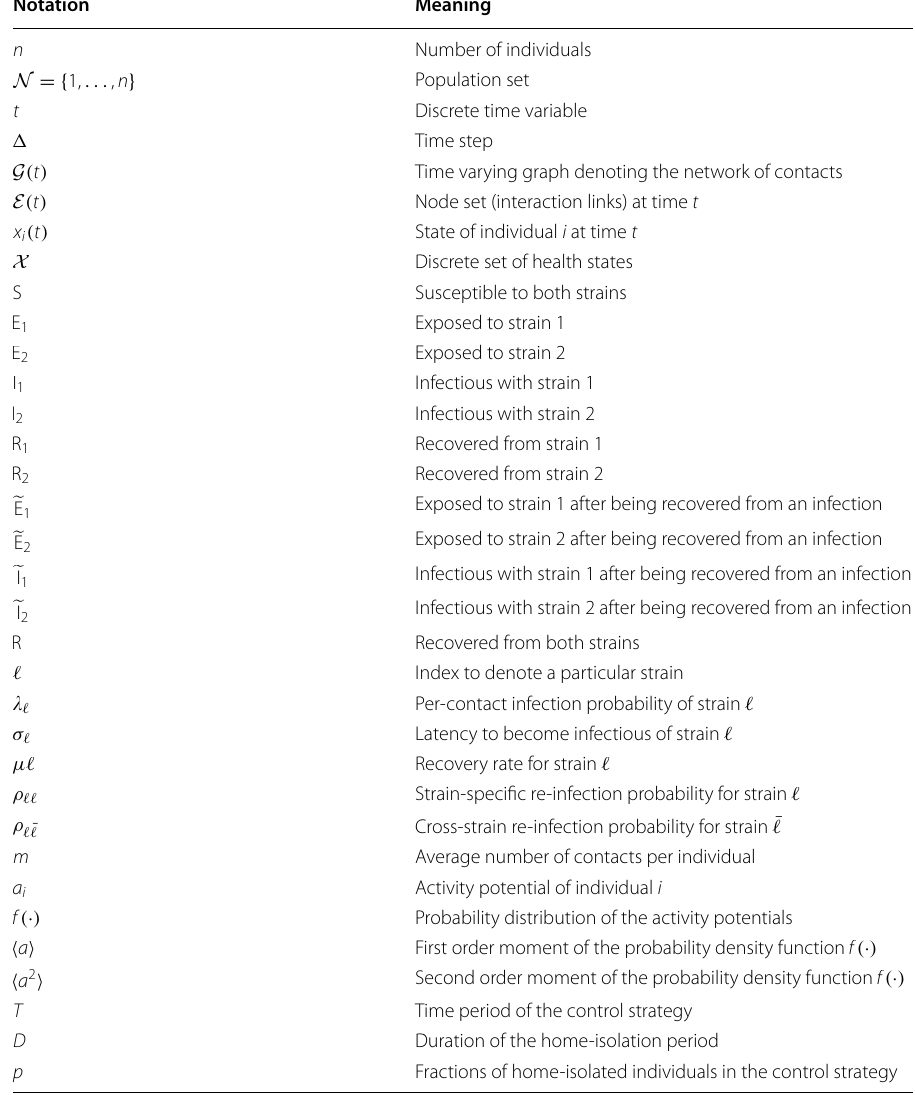
Table 1 Notation used in the